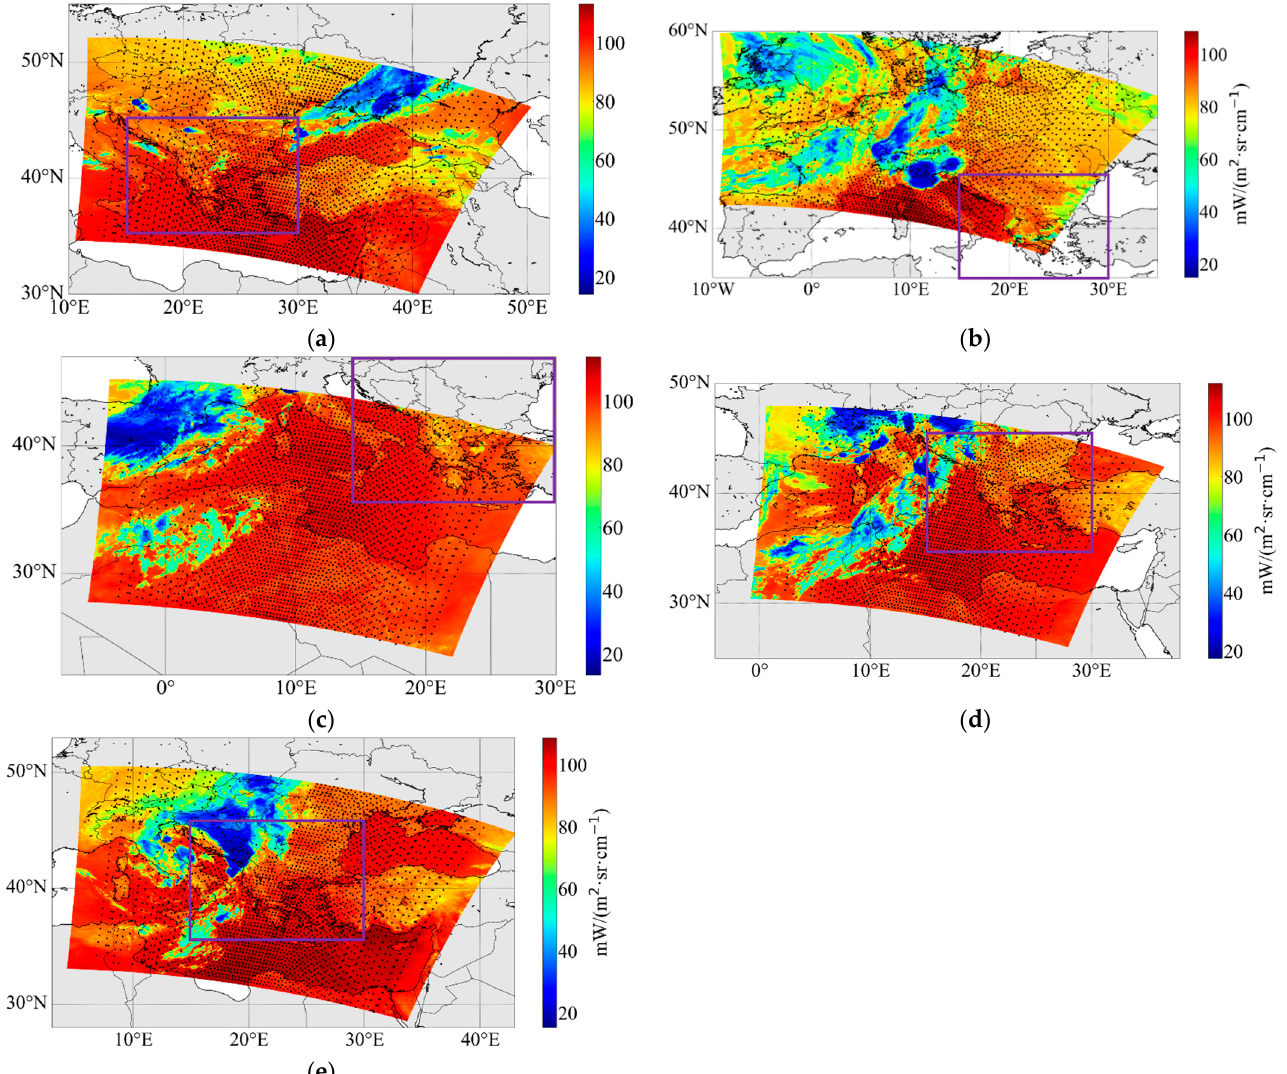
Figure 6. Clear-sky pixel selection. The satellite observation test data are as follows: ( a ) 1 August 2020, 00:05